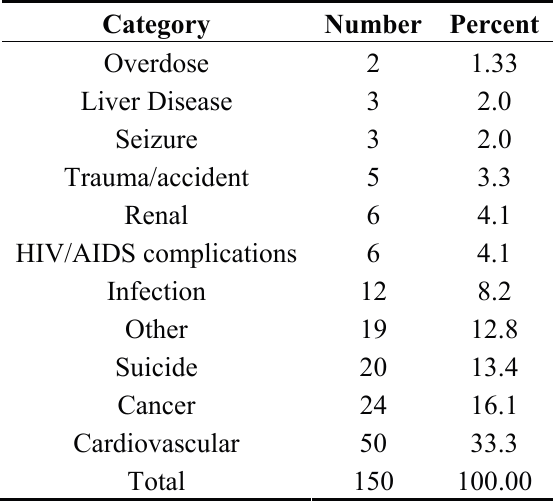
Table 2. Deaths by Cause ( n =